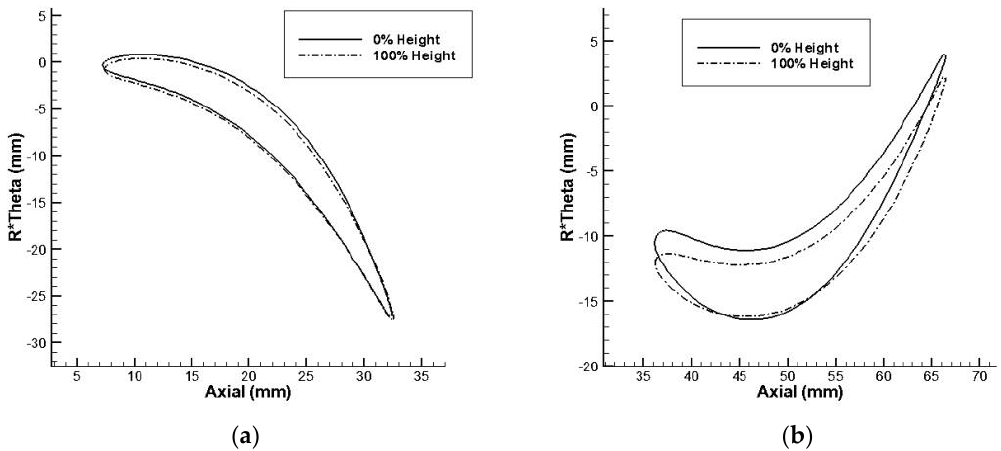
Figure 4. The profiles of the conventional tip turbine: ( a ) profiles of the stator; ( b ) profiles of the